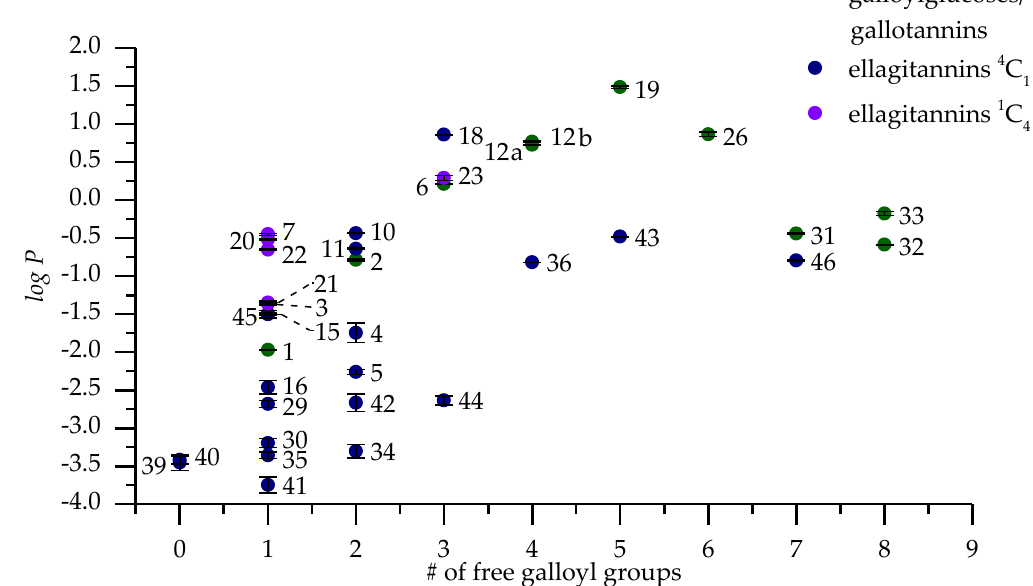
Figure 4. LogP values measured with UPLC and plotted against the number of free galloyl groups in the structures of hydrolysable tannins. The numbers refer to Figures 1 and 2 and Table A1. When 1,2,3,4,6-penta- O -galloyl-β- D -glucose ( 19 ) is galloylated further into hexa- ( 26 ), hepta- ( 31 )